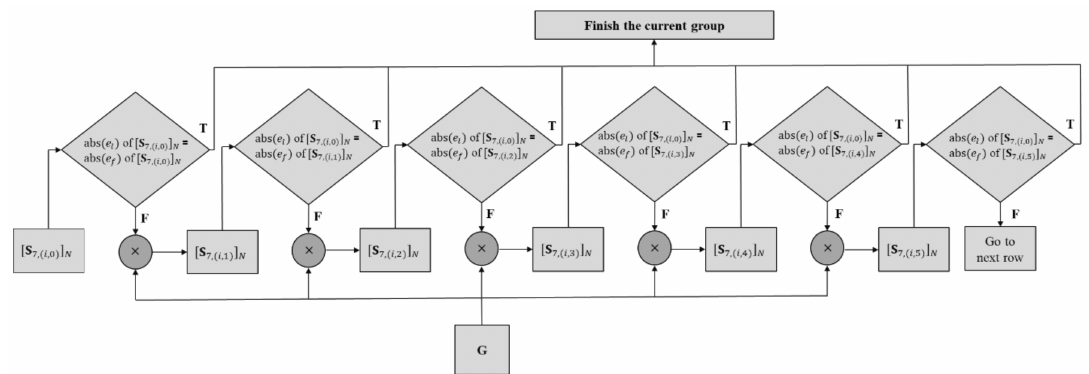
Figure 7. An example of derivation process for the i -th group of 32-point